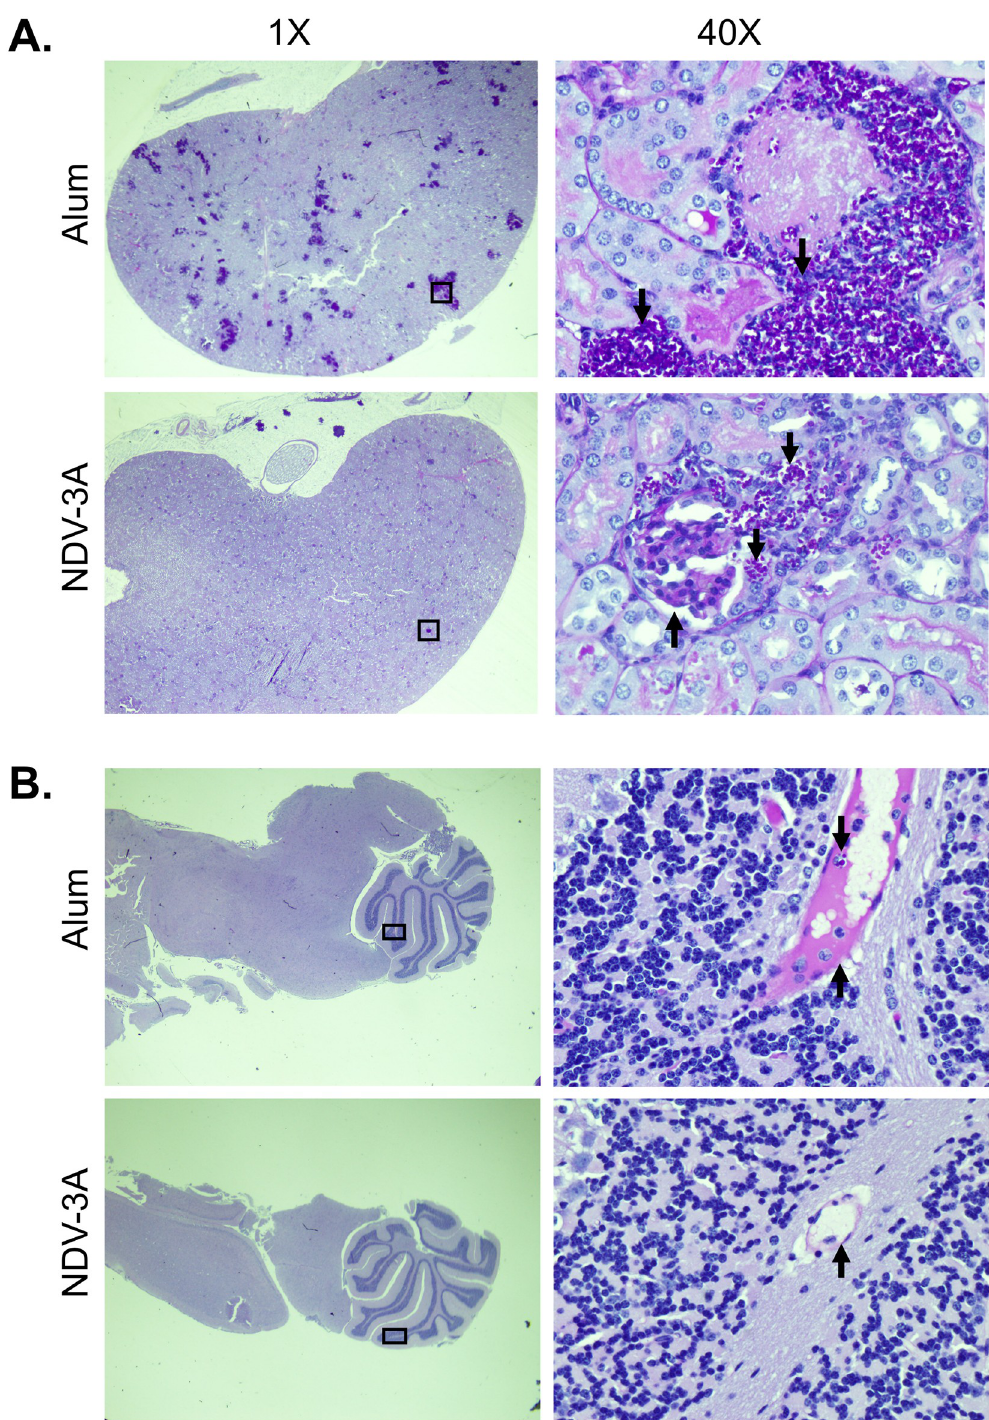
Fig 6. Comparison of histopathology of kidneys and brain tissue sections from NDV3-A-or alum-vaccinated and C . auris infected mice. Tissue sections obtained on 4 days after the infection were stained with PAS. (A) Kidneys . The kidney from the control alum mouse had numerous abscesses with visible C . auris fungal cells throughout the tissue. (B) Brain . NDV-3A- vaccinated mouse did not show any visible abscesses or C . auris organism but alum mouse brain was visibly infected with C . auris . The arrow facing down show the C . auris in the tissues, and arrows facing up show the blood